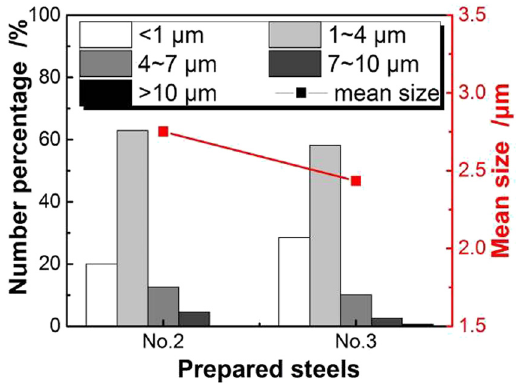
Figure 9: Effect of Al on the size of inclusions in